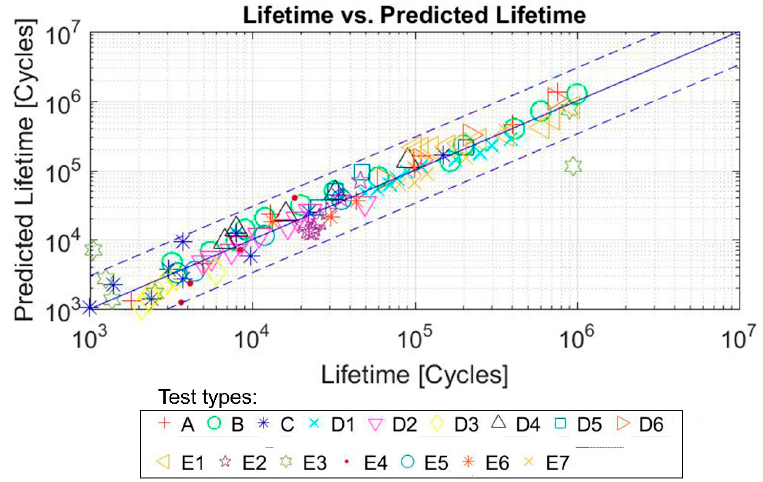
Figure 15. Predicted life (cycles) with FDMP versus real life (cycles) for SBR tests. Initial data from [46].